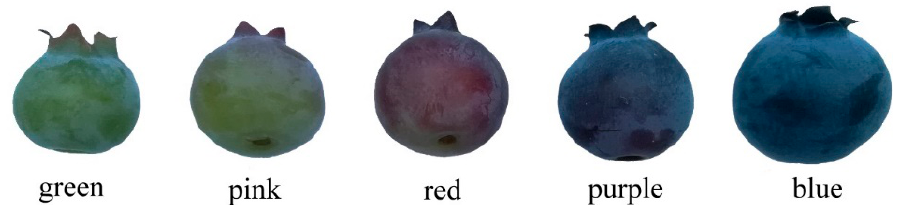
Figure 6. Developmental stages of blueberry fruit used for phytochemical profiles and antioxidant activity analyses.